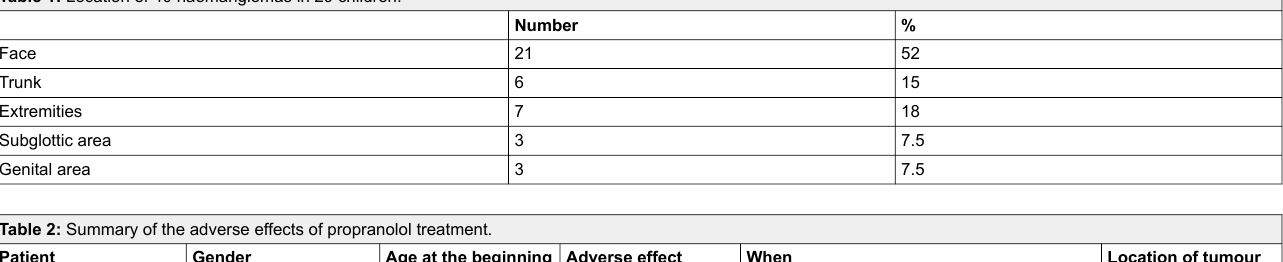
Table 1: Location of 40 haemangiomas in 29 children.